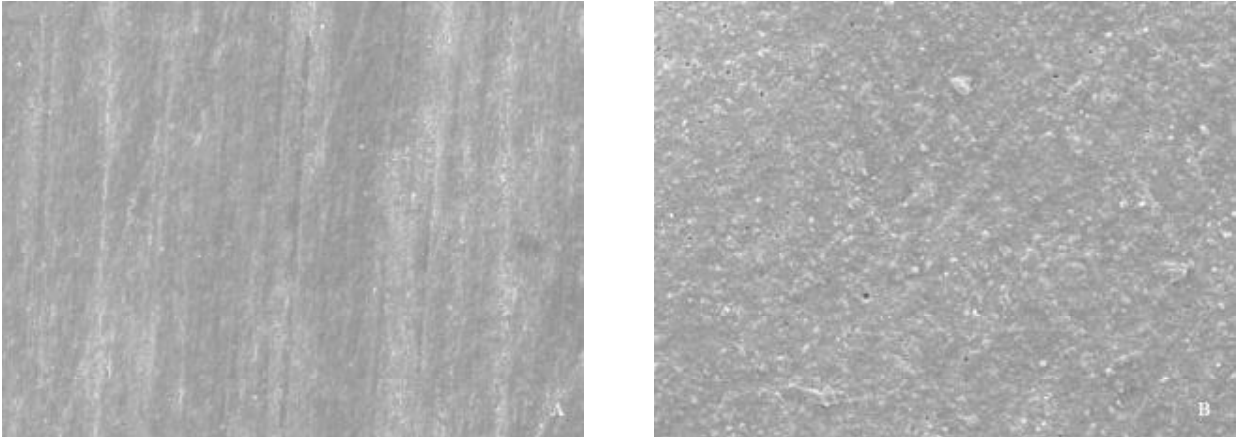
FIGURE 2- Admira ORMOCER composite: (A) after polishing with Sof-Lex discs and before the mechanical toothbrushing test; (B) after the mechanical toothbrushing test. Original magnification 2500x